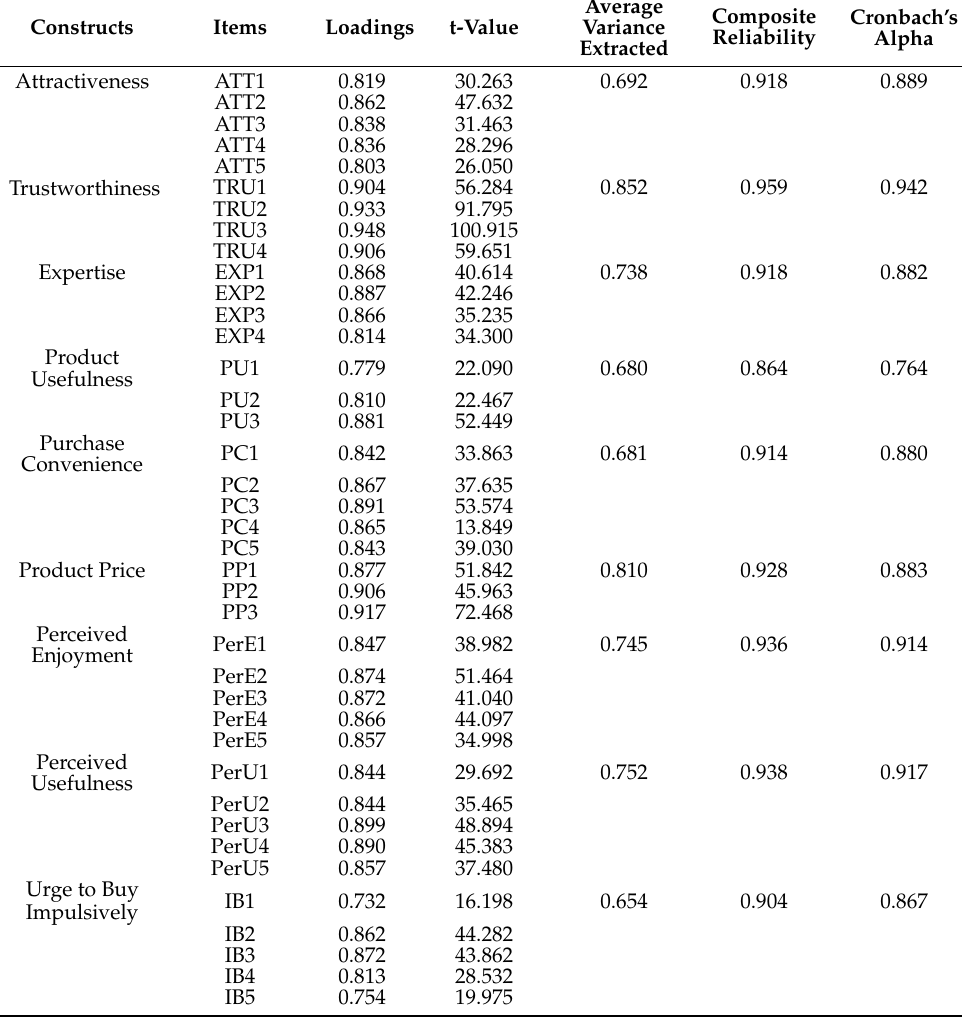
Table 2. Construct on reliability and validity.